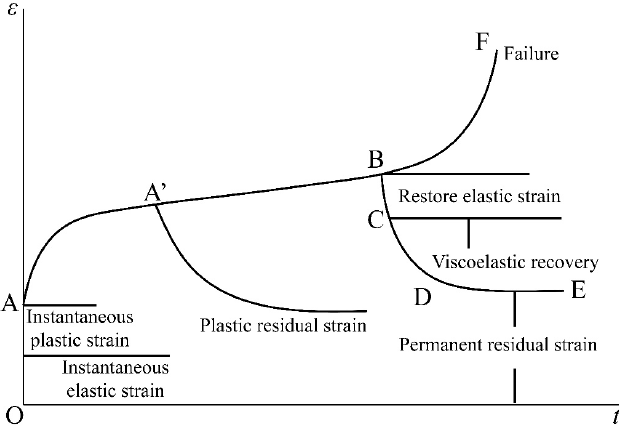
Figure 3. Typical creep